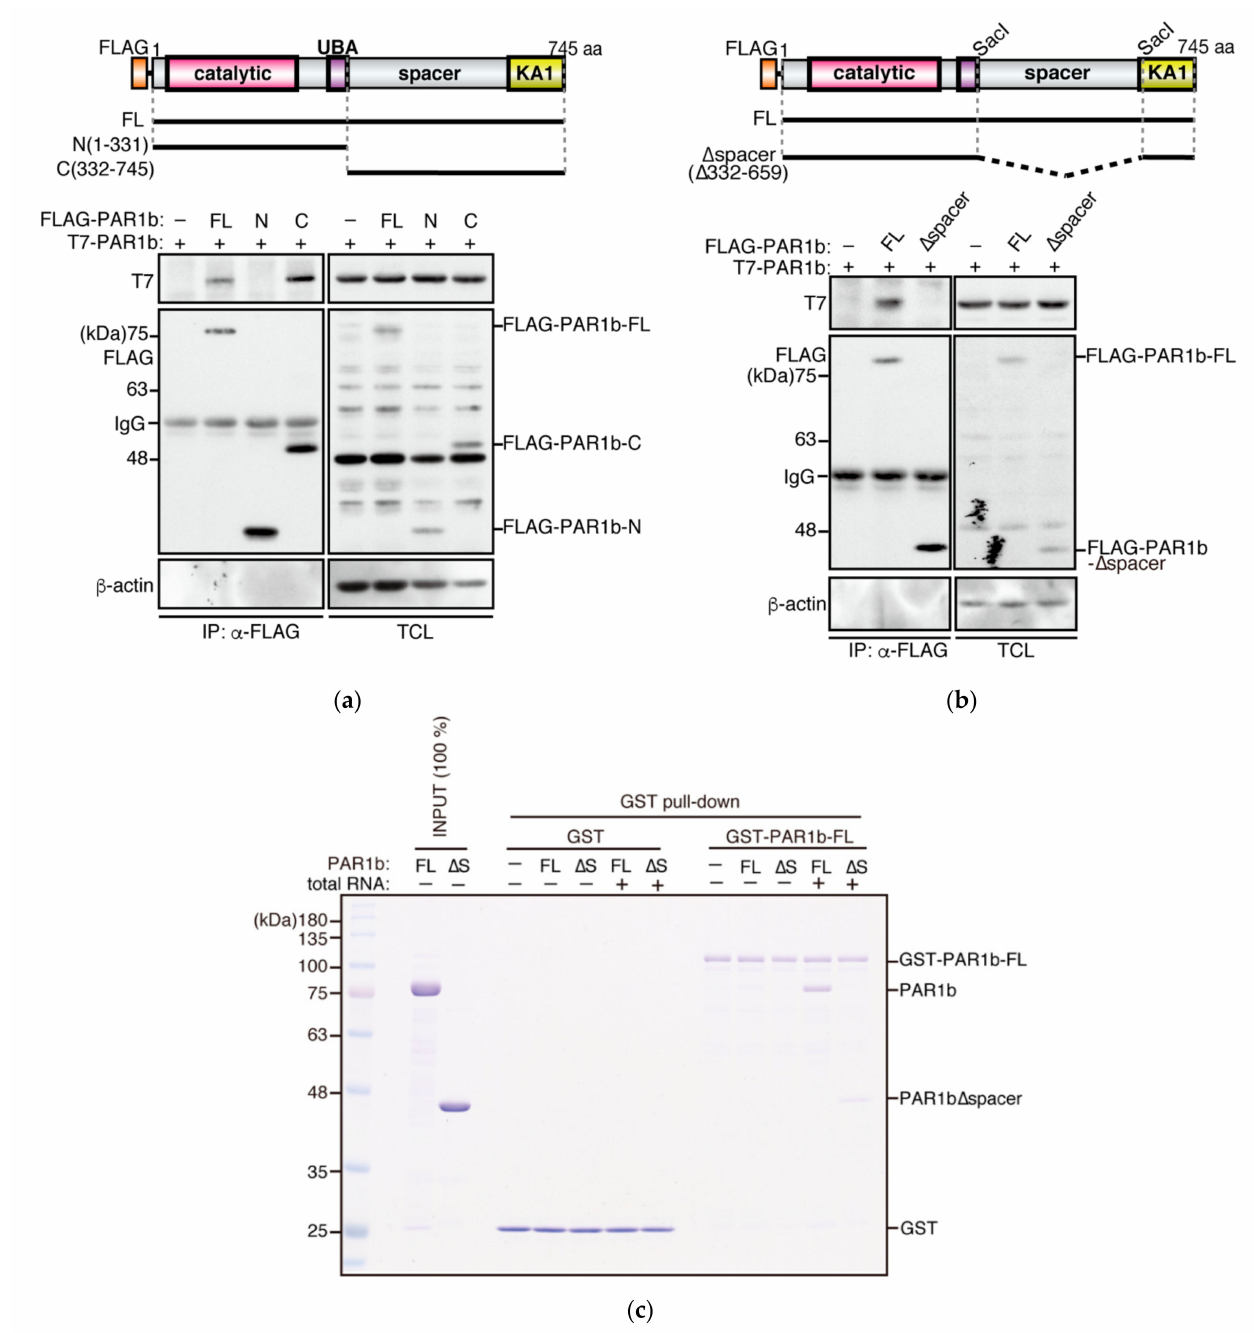
Figure 2. Mapping the multimerization domain of PAR1b. ( a ) The C-terminus of PAR1b is required for multimerization in cells. Schematic diagram of full-length (FL) FLAG-PAR1b and its N-terminal and C-terminal truncations (top) . Amino acid residue numbers refer to the 745 aa isoform of PAR1b (see Methods). AGS cells transiently transfected with expression vectors for the FLAG-PAR1b mutants and T7-PAR1b were subjected to immunoprecipitation (bottom) . ( b ) The spacer region is required for multimerization in cells. Schematic diagram of FLAG-PAR1b- ∆ spacer (top) . AGS cells transiently transfected with the expression vectors for FLAG-PAR1b- ∆ spacer and T7-PAR1b were subjected to immunoprecipitation (bottom) . ( c ) PARb multimerizes primarily through the spacer region in the presence of nucleic acid. GST-PAR1b-FL bound Glutathione Sepharose beads were mixed with 100 nM PAR1b-FL or PAR1b- ∆ spacer in the presence of 1 µ g/mL total RNA and a GST pull-down assay was